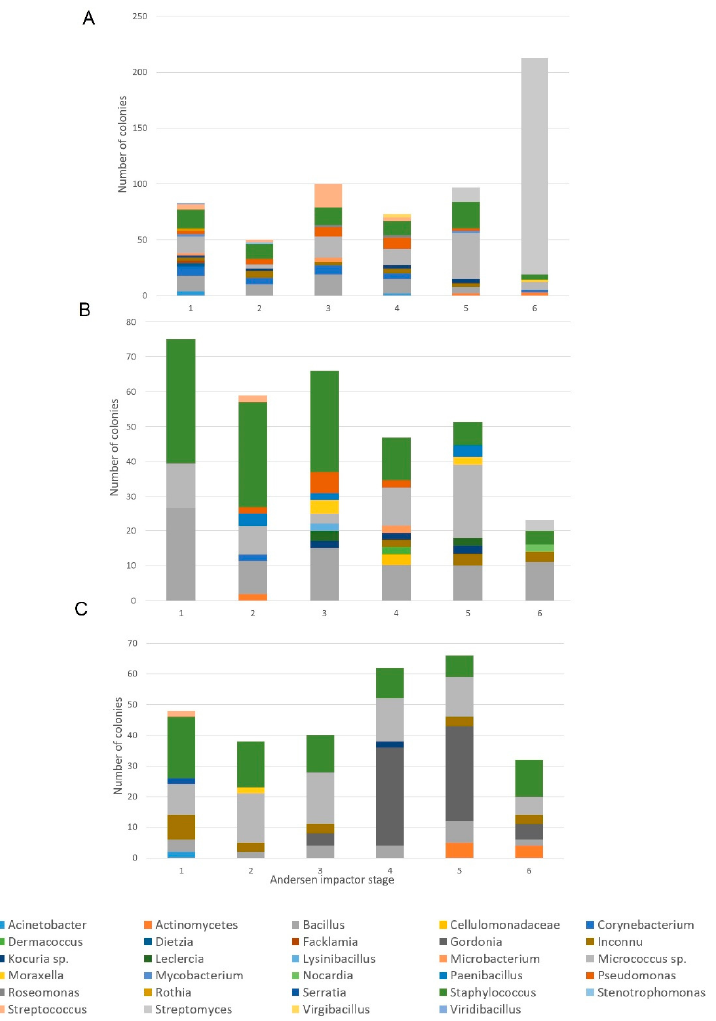
Figure 8. Identification and the number (CFU) of culturable bacteria collected with the Andersen impactor for 15 min in lab A ( top ), lab B ( middle ) and Lab C ( bottom ). Concentrations are reported according to the size of the particles impacted on each of the six stages of the impactor on the agar surface. Only genera presented more than once on a given sample are reported. Bacteria sizes are mostly between 0.5 and 3 µm [42]. However, bioaerosols are not always present as separate microbial cells in the air; they agglomerate with other particles [43,44]. The degree of the agglomeration of microbial cells is influenced by several factors, including the type of bacteria, other particles, the relative humidity, the source, substra- tum, the emission mechanism, and air movement velocities [45,46]. Studies have shown that when there are higher amounts of dust, the association of microorganisms and dust is more frequent [43]. Since lab B was adjacent to a garage with higher dust and exhaust levels, this could explain the higher agglomeration frequency. When assessing microbial risk, it is important to consider the microbial load that may be respirable. In the outdoor